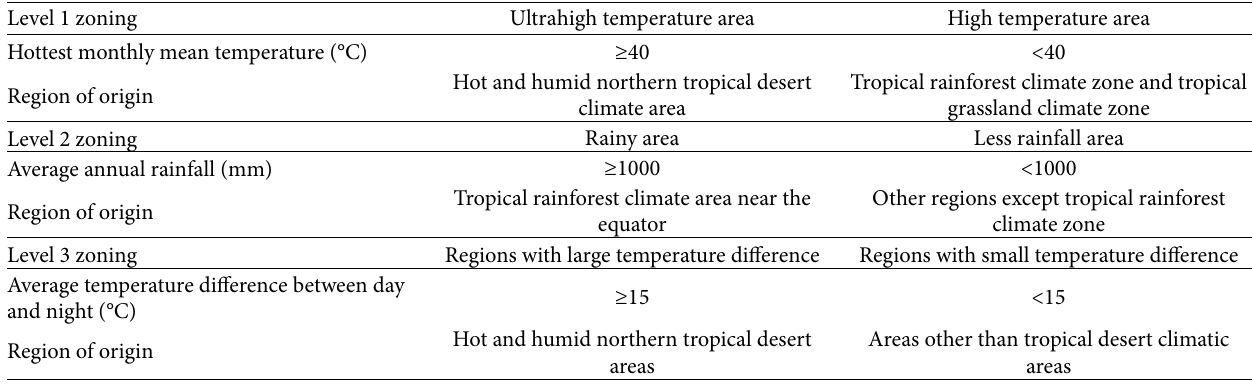
Table 7: Three-stage climate zoning of airport overlay in hot and humid area.